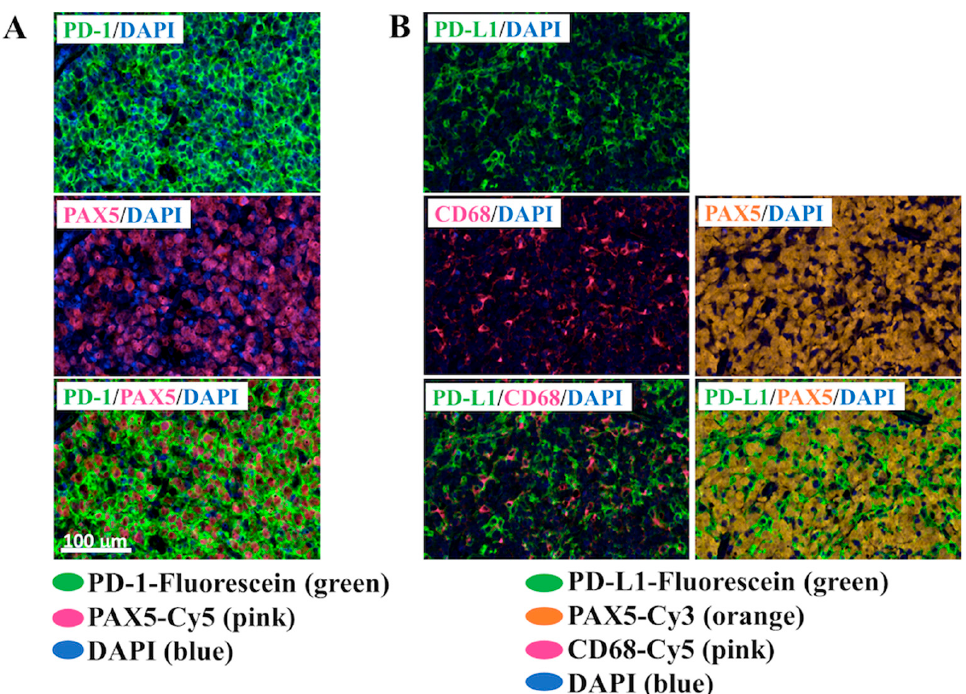
Figure 1. Representative multicolor immunofluorescent staining images of a patient with de novo DLBCL. ( A ) PD-1 (green) was expressed by PAX-5 (pink)-positive cells, which represent DLBCL cells. The lower panel is a merged image of the upper and middle panels. ( B ) PD-L1 (green) was expressed by CD68 (pink)-positive cells, which represent macrophages, in the TME, but not by PAX-5 (orange)-positive cells. The lower panels are merged images of the PD-L1/DAPI panels and middle panels. The images were captured using a digital pathology slide scanner (Aperio CS2 (Leica Biosystems, Richmond, IL, USA)) and analyzed using Aperio ImageScope software. PD-1,